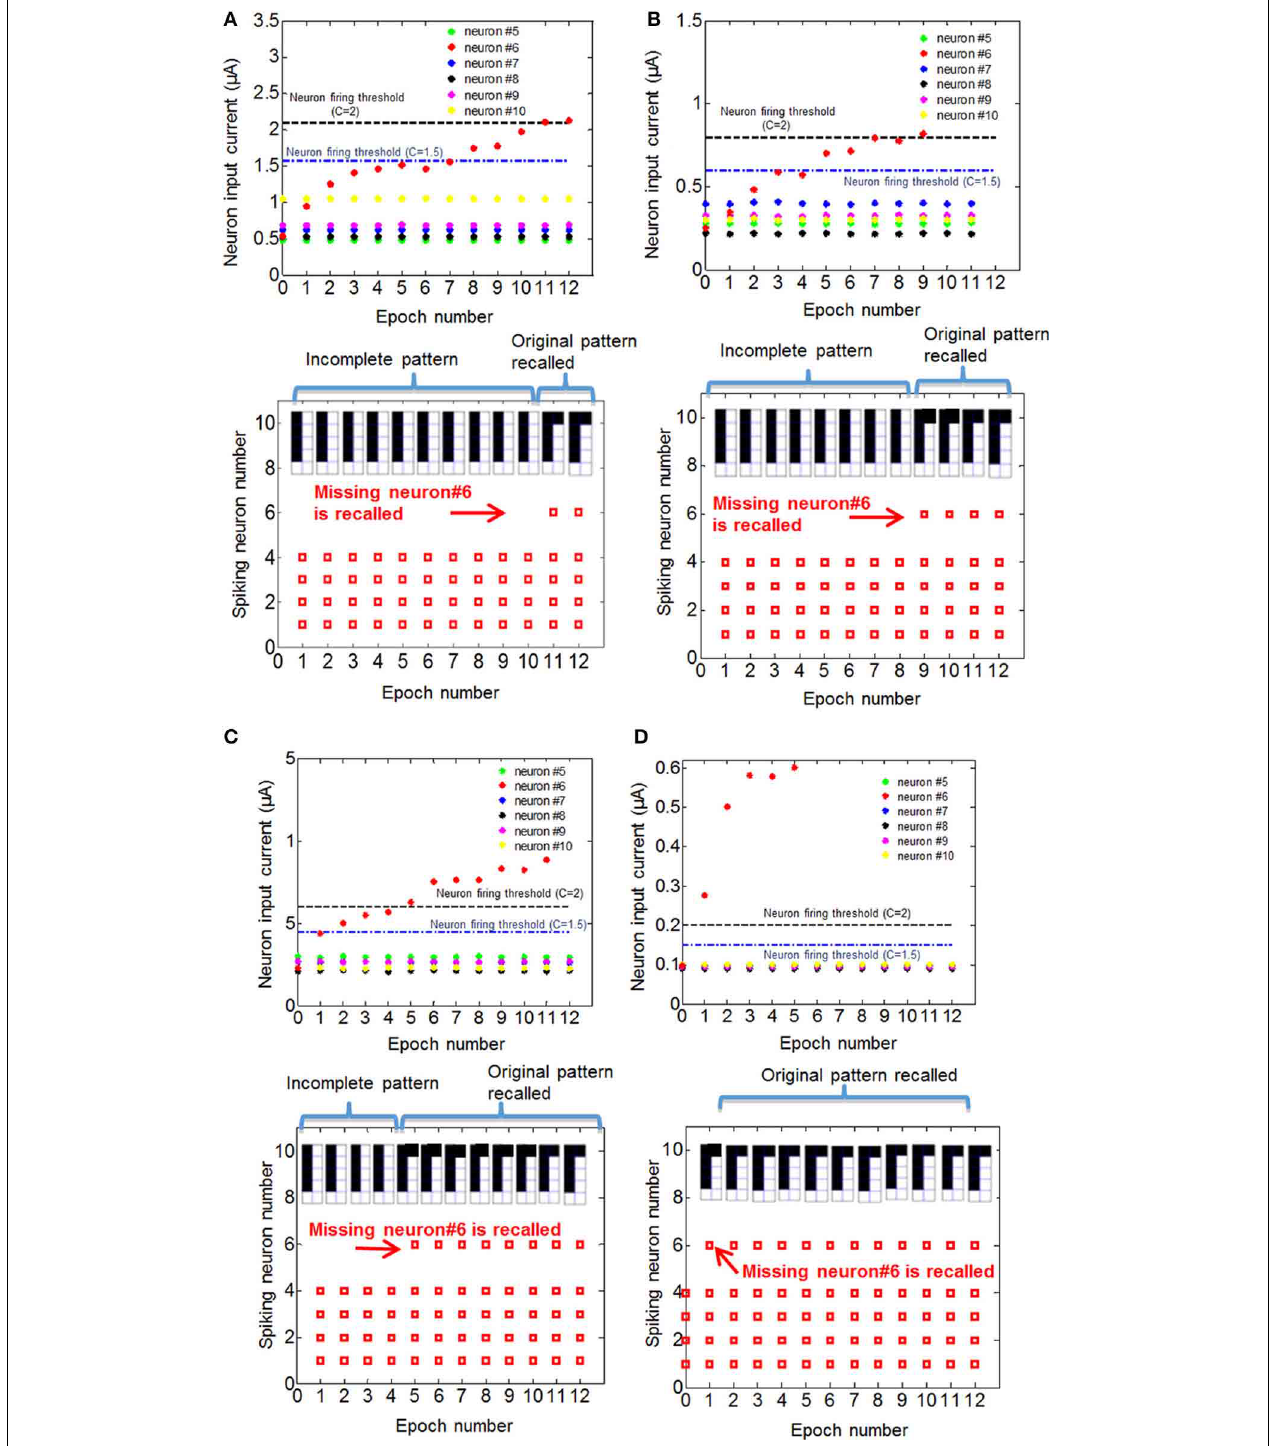
FIGURE 6 | Recall of the missing pixel for training with pattern 1 for four different initial variation cases, (A) 60%, (B) 40%, (C) 24%, and (D) 9%, are shown. For each case, top figures show what the input current of neurons that do not fire would be if the recall is performed after the corresponding number of epochs, and bottom figures show the neurons that fires if the recall was performed after the corresponding number of epochs